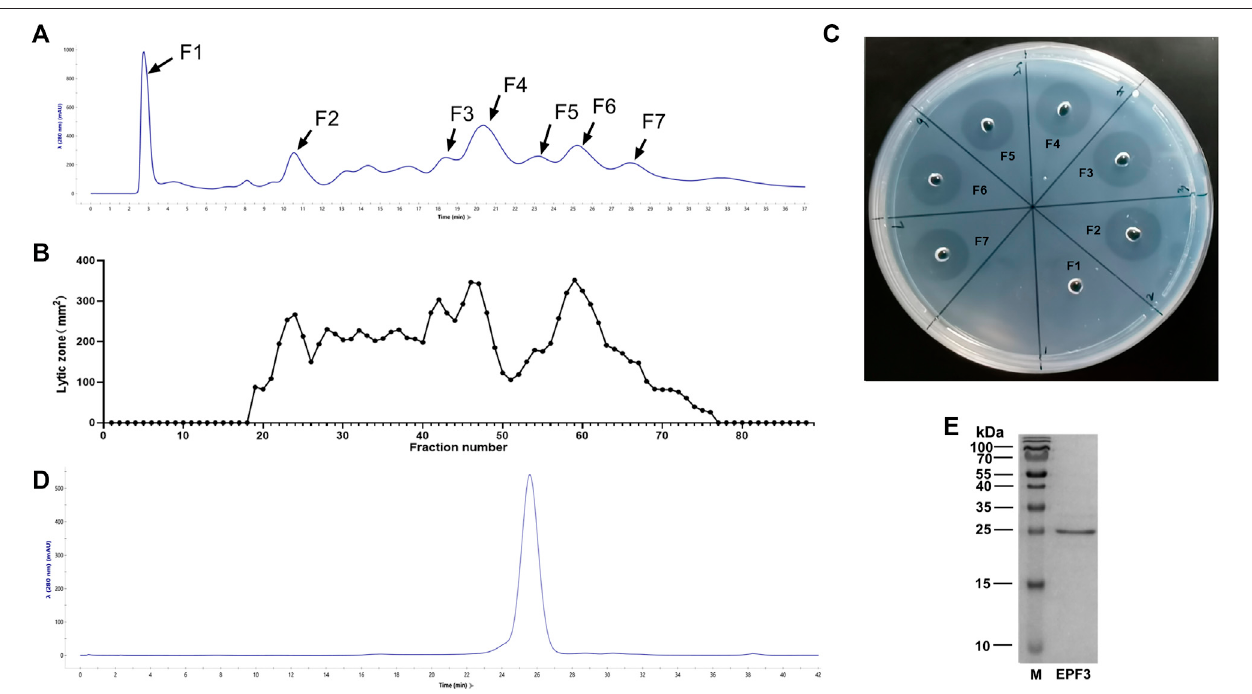
FIGURE 1 | Puri fi cation of fi brinolytic proteins. (A) Ion-exchange chromatography of P. vulgaris crude extract presenting 7main peaks, the absorbance at 280 nm was shown at the axis. (B) The area of the lytic zone of 88 eluted fractions. (C) The fi brin-plate assays of 7 main chromatographic peaks. (D) Size exclusion chromatography of F3 presenting 1 main peak, the absorbance at 280 nm was shown at the axis. (E) SDS-PAGE pro fi ling of EPF3, in which M represents protein marker, and EPF3 appears as a single band.